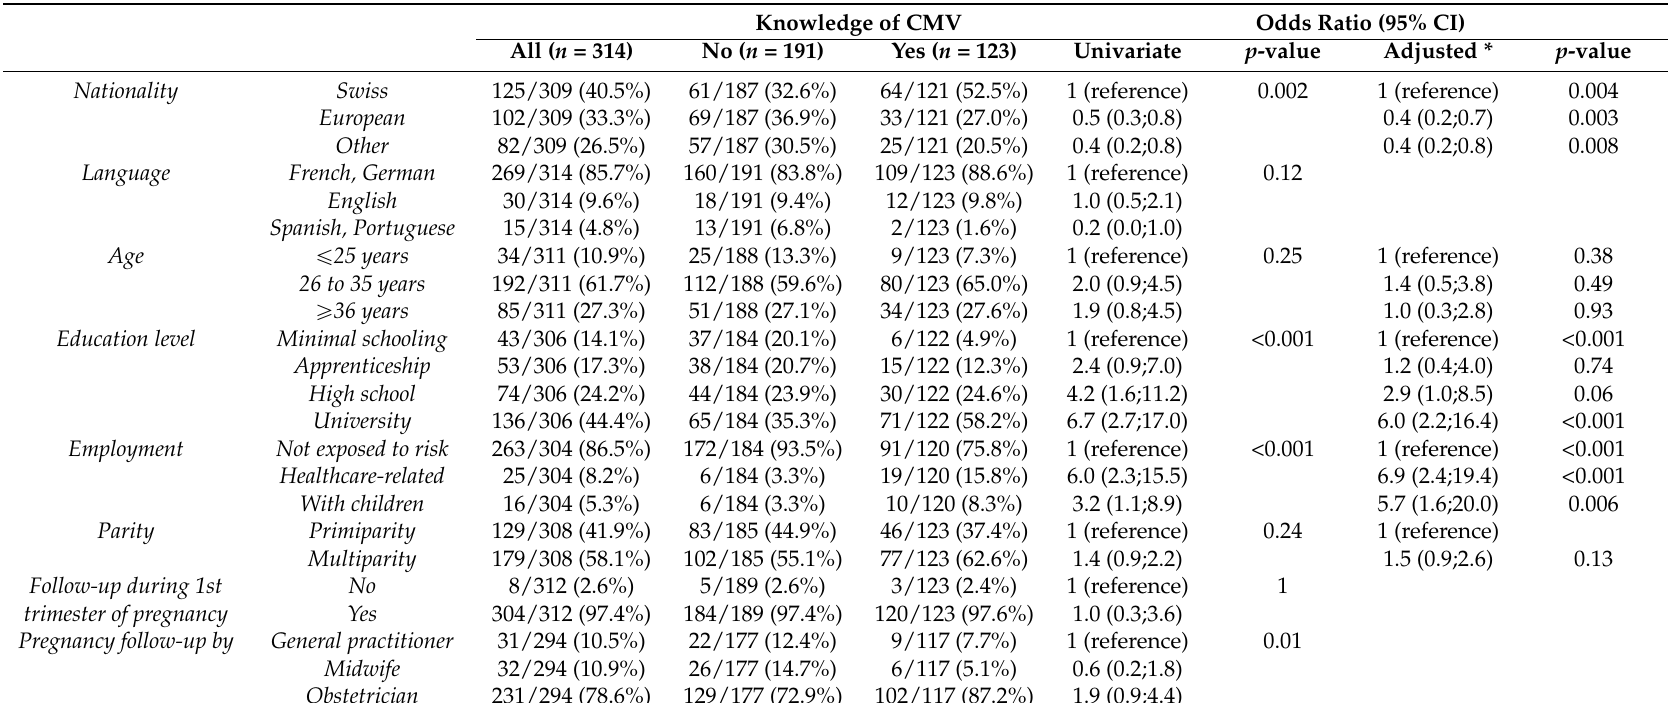
Table 1. Sociodemographic characteristics of